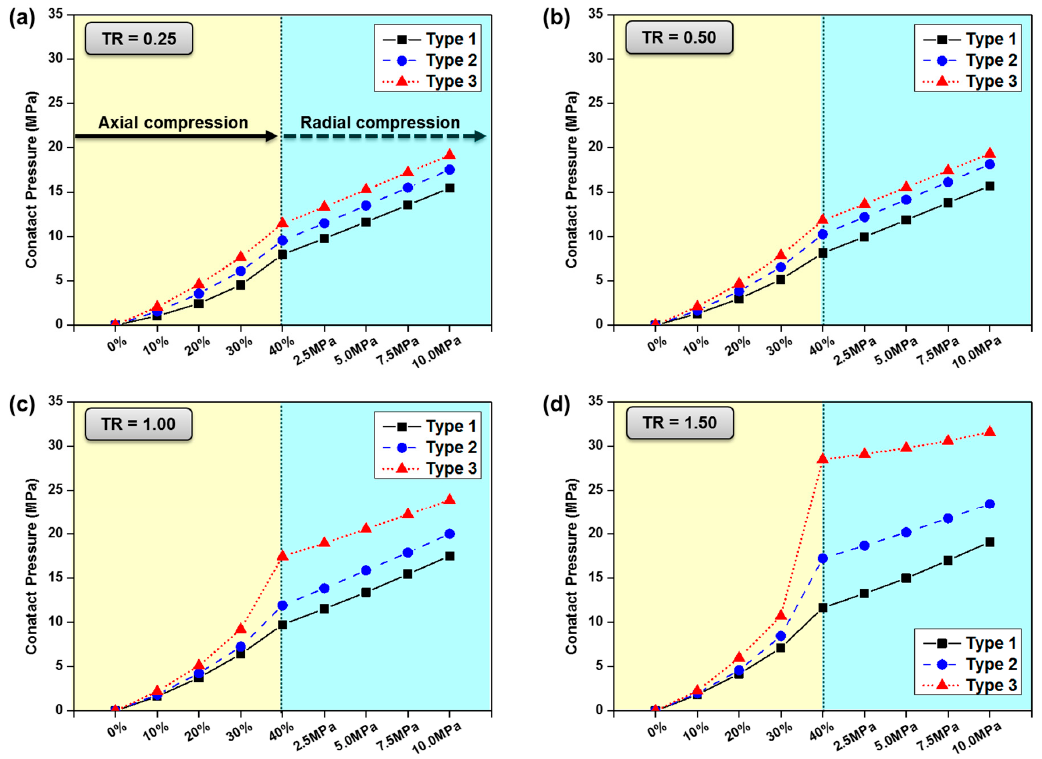
Figure 8. Changes in average contact pressure with axial and radial compressions. The yellow area indicates axial compression from 10% to 40% of the compression ratio during assembly. The blue area represents radial compression from 2.5 to 10.0 MPa of the internal pressure during operation: ( a ) TR = 0.25; ( b ) TR = 0.50; ( c ) TR = 1.00; and ( d ) TR = 1.50.